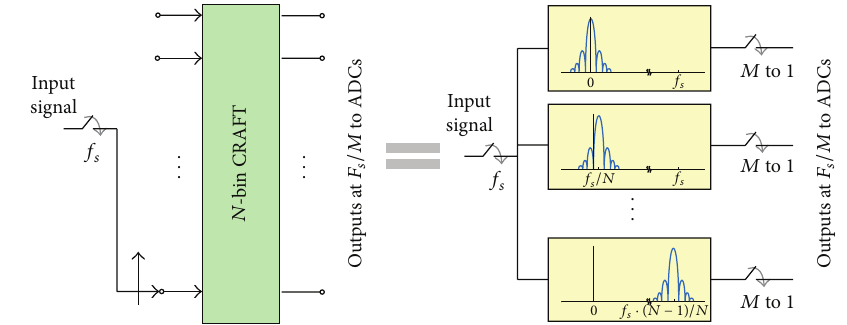
Figure 11: The functional equivalence of the DFT with frequency domain outputs and a time-domain 𝑁 -path complex-bandpass filter bank.